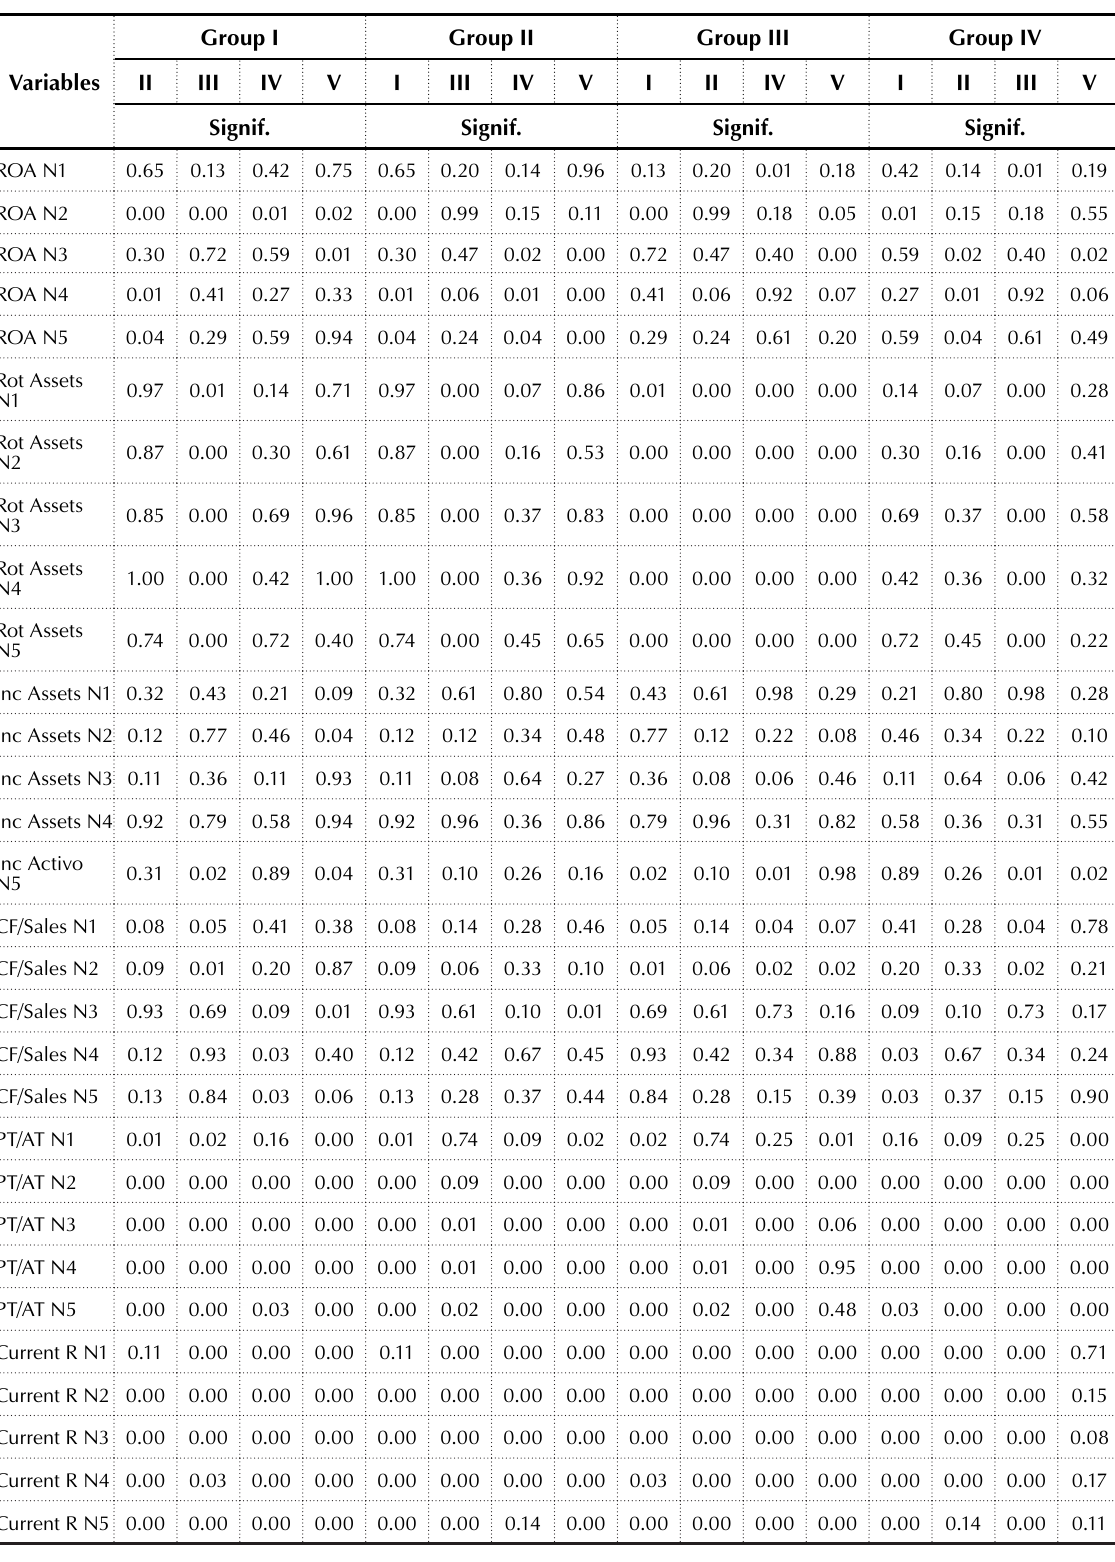
Table 5. Contrast of independent sub-samples. Groups taken two by